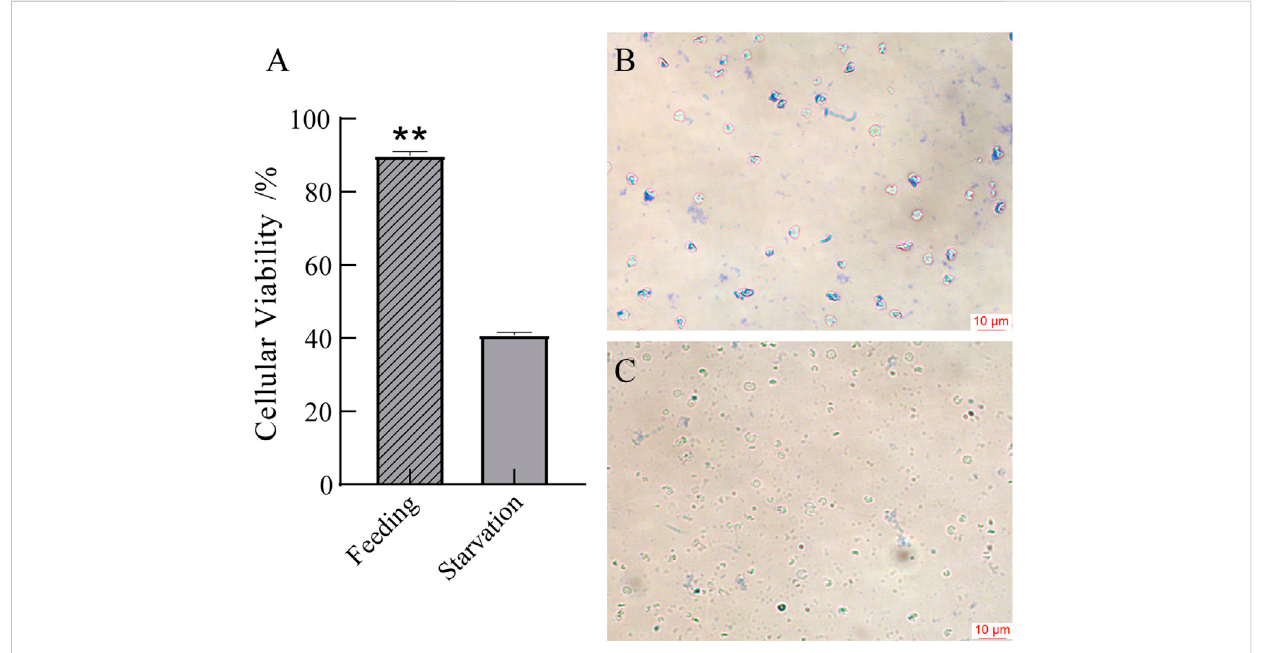
FIGURE 7 Cellular viability in blood (A) and microscopic observation of blood in the feeding group (B) and the starvation group (C) . * p < 0.05 or ** p < 0.01 versus starvation group.